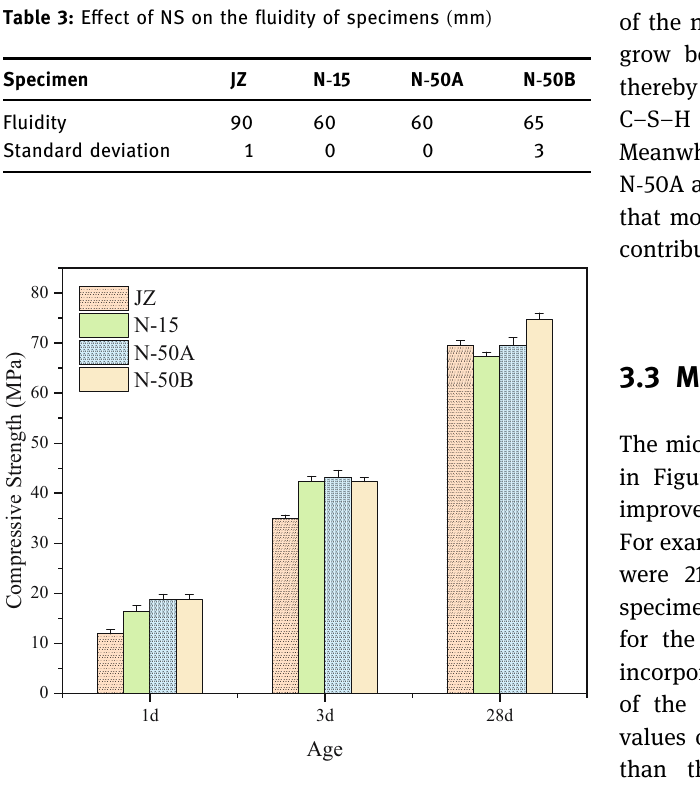
Figure 1: Compressive strength of